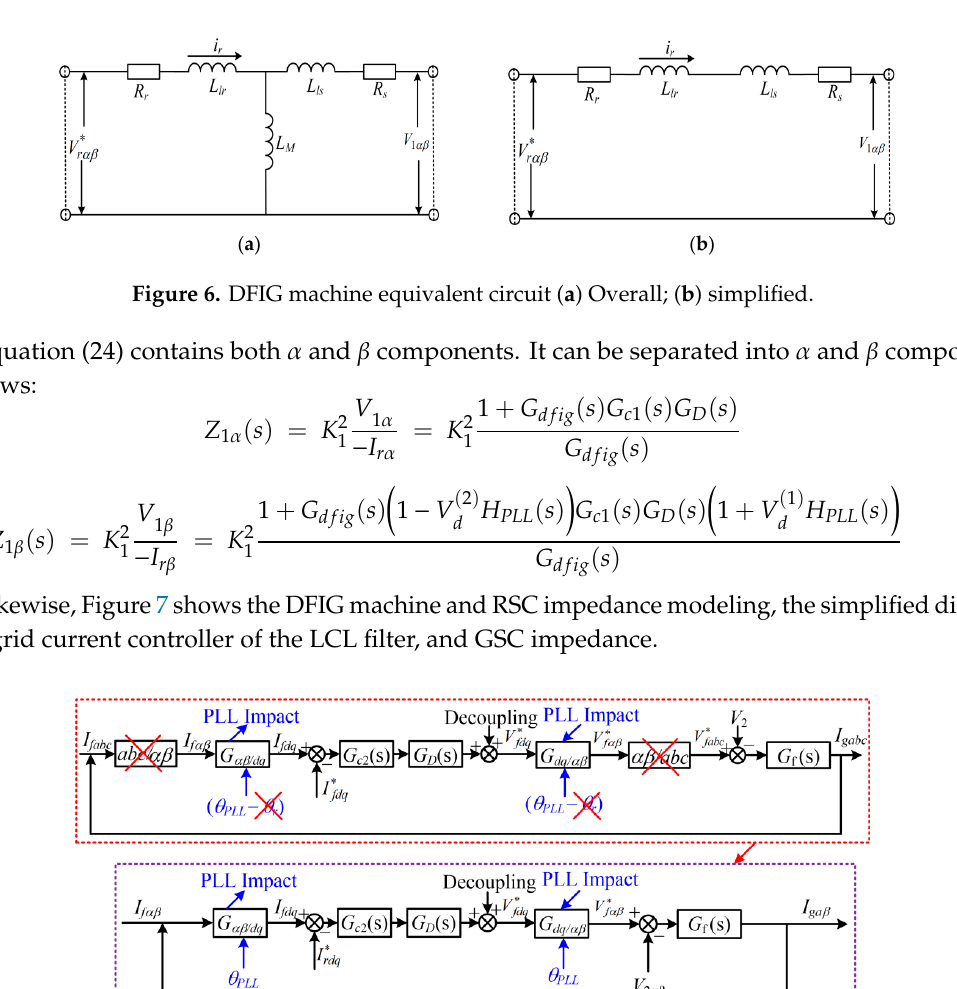
Figure 7. Simplified control diagram of GSC and LCL filter.